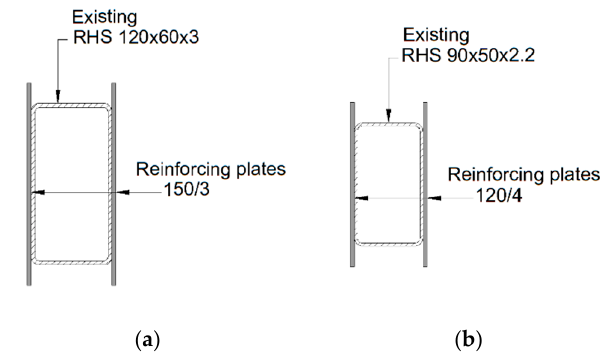
Figure 19. Reinforcing steel columns by welding steel plates: ( a ) Venlo-type and ( b ) vaulted greenhouse.